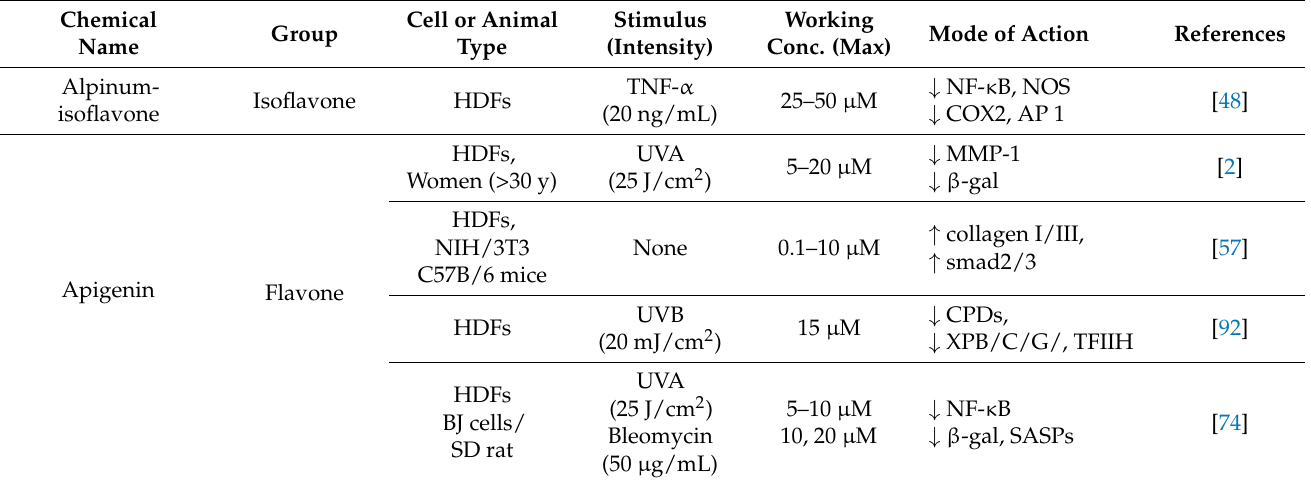
Table 1. Role of each polyphenol compound and its underlying mechanism for improving aged dermal